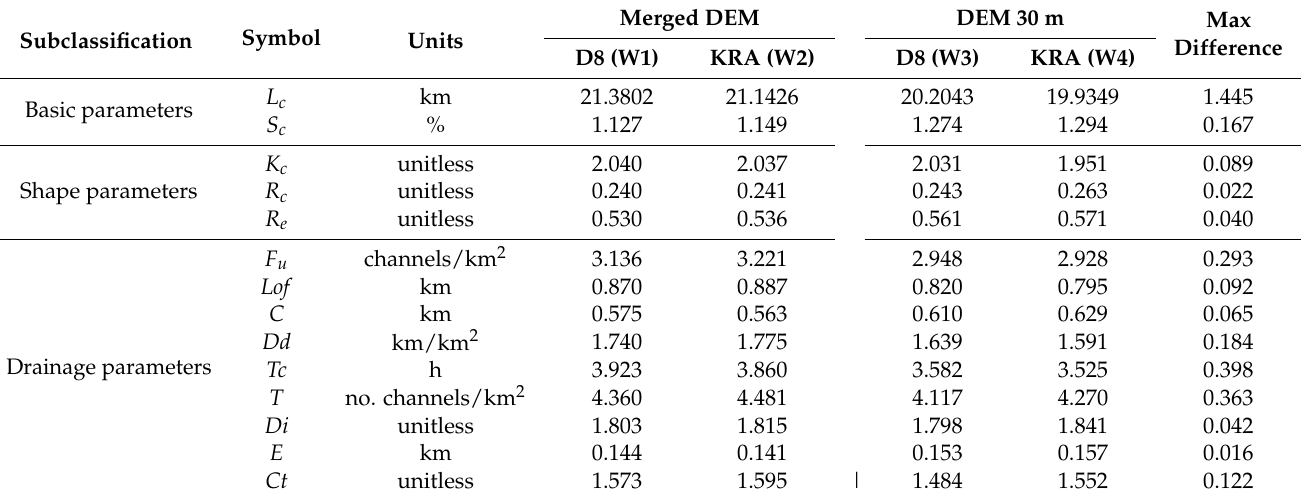
Table 7. Quantitative